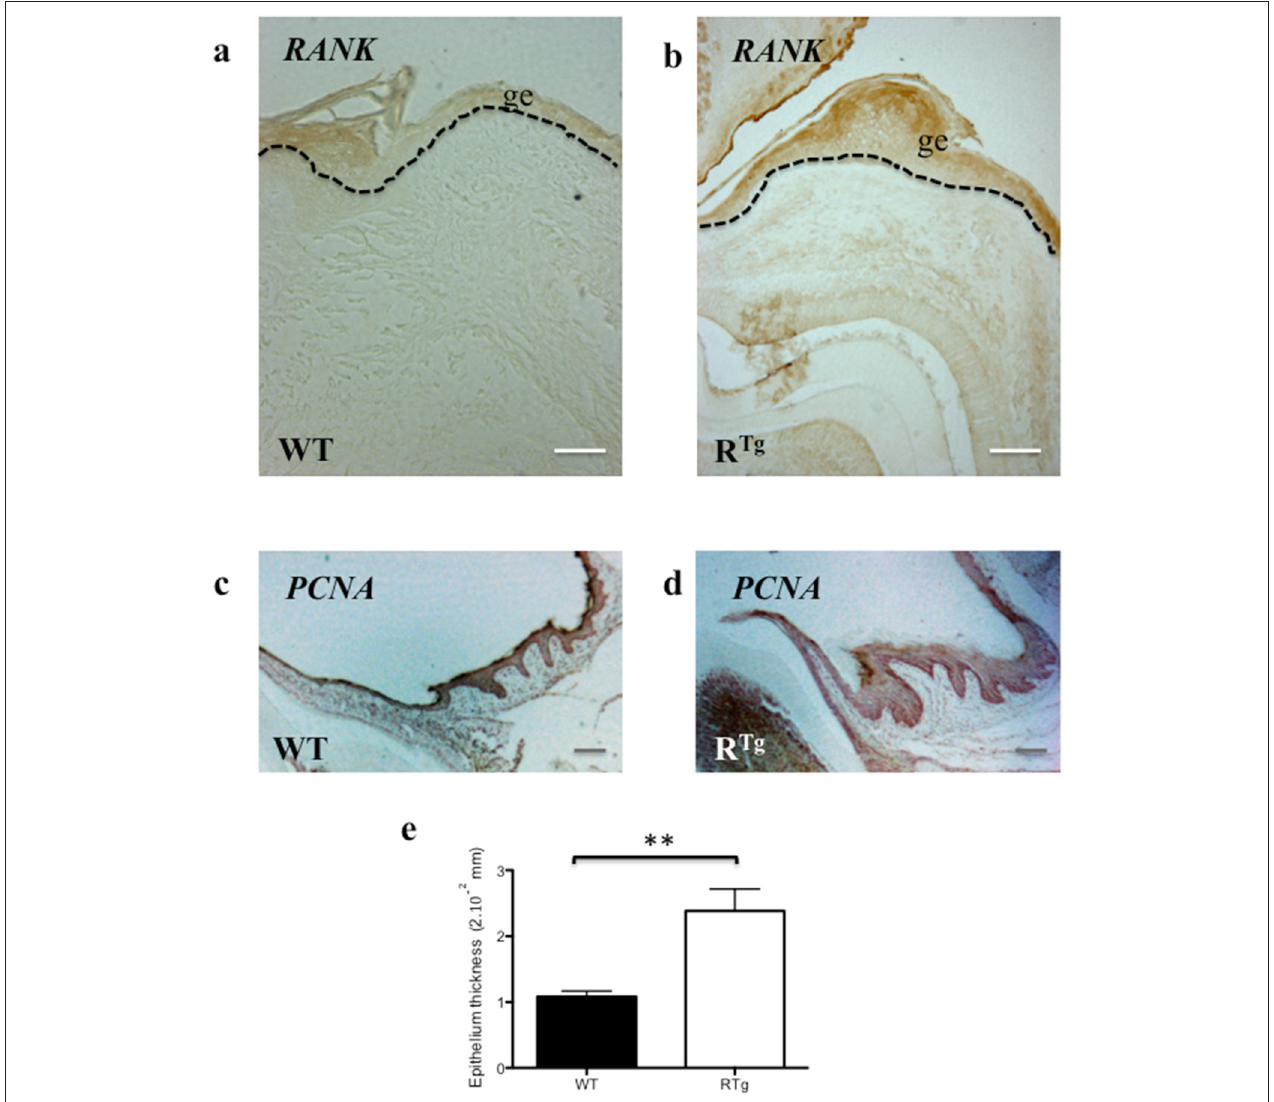
FIGURE 6 | Immuno-histochemistry analyses of RANK and PCNA expressions comparatively in WT and R Tg mice. The RANK expressing gingival epithelium thickness was already increased in 5 day-old transgenic mice comparatively to WT (a,b) . PNCA staining performed on sections of at 25 day-old WT and R Tg evidenced that gingival epithelium thickness increase is associated to an increase of proliferative cells number (c,d) . Measurement of the epithelium thickness performed on these sections evidenced a significant increase (** p < 0.01) in the R Tg mice (e) . ge, gingival epithelium. Scale bars in a,b correspond to 50 µ m and in C,D to 20 µ